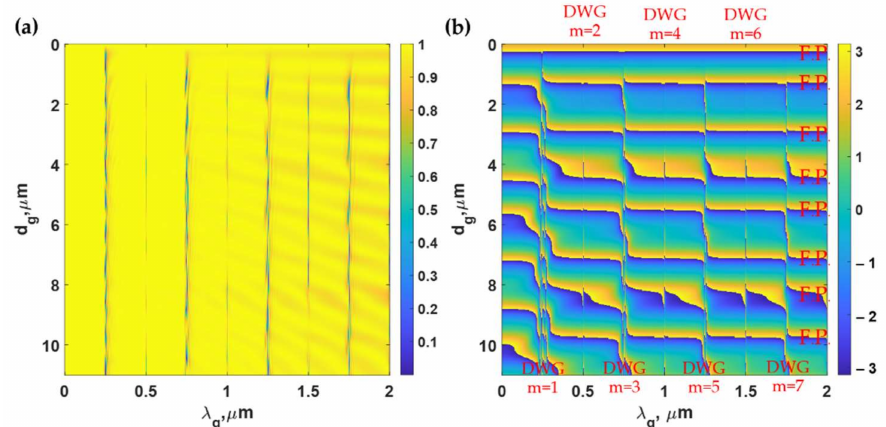
Figure 5. ( a ) Reflectance and ( b ) phase responses in rad of the reflection coefficients calculated using rigorous coupled-wave analysis (RCWA) for PDMS gratings when the grating period λ g was varied from 0 µ m to 2 µ m, and the grating groove depth d g was varied from 0 µ m (uniform PDMS layer 11 µ m thick) to 11 µ m when illuminated by transverse magnetic (TM) polarized light at 685 nm and the n 0 sin θ 0 of